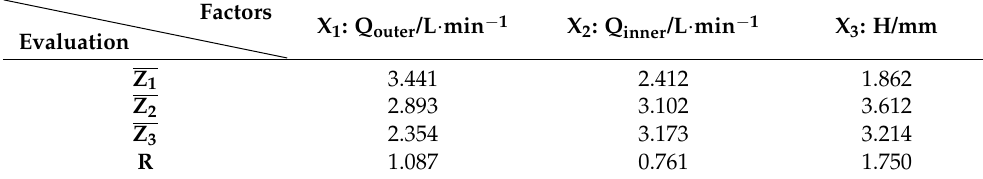
Table 5. Evaluation indices of the orthogonal experiment design